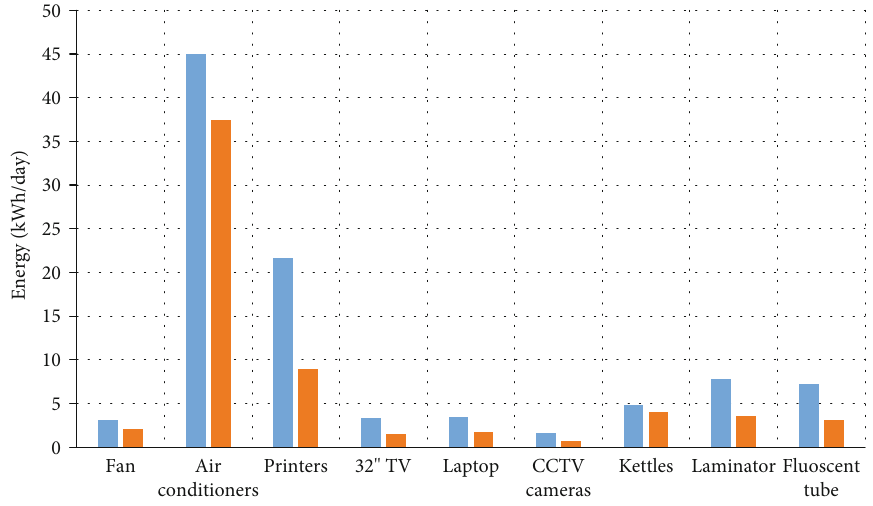
Figure 2: Comparing energy saving of selected Table 4: Cost of recommended appliances (US$1 equal to MKW